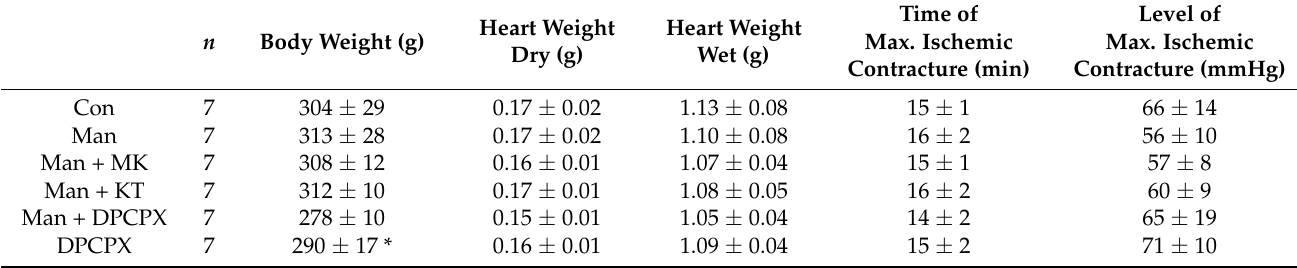
significantly lower compared to Man.